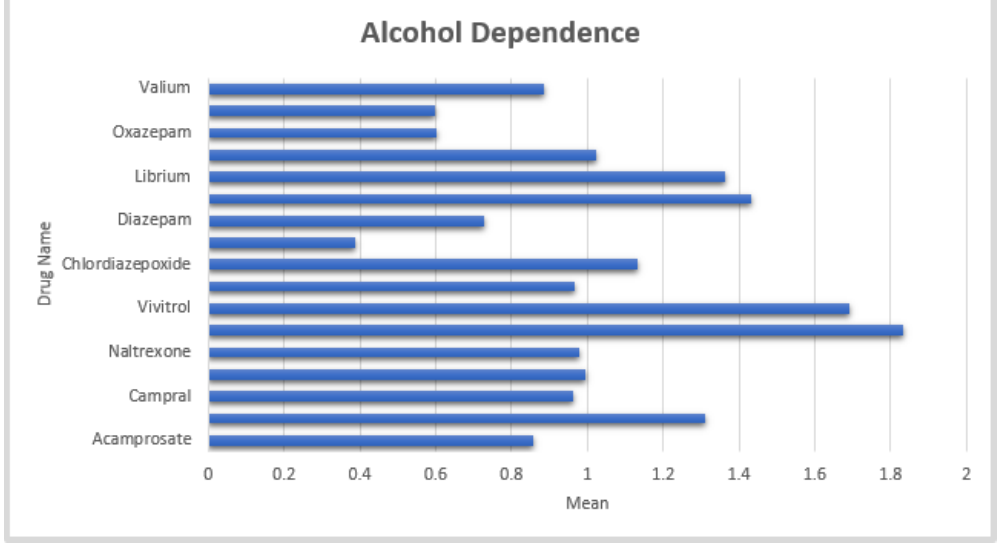
Figure 21. Drug prediction results of alcohol dependence condition